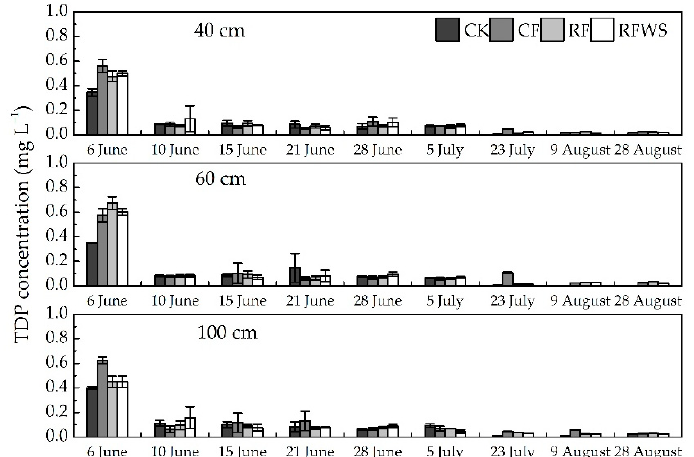
Figure 6. Changes in TDP concentration in leaching water at different depths under different fertilization treatments.